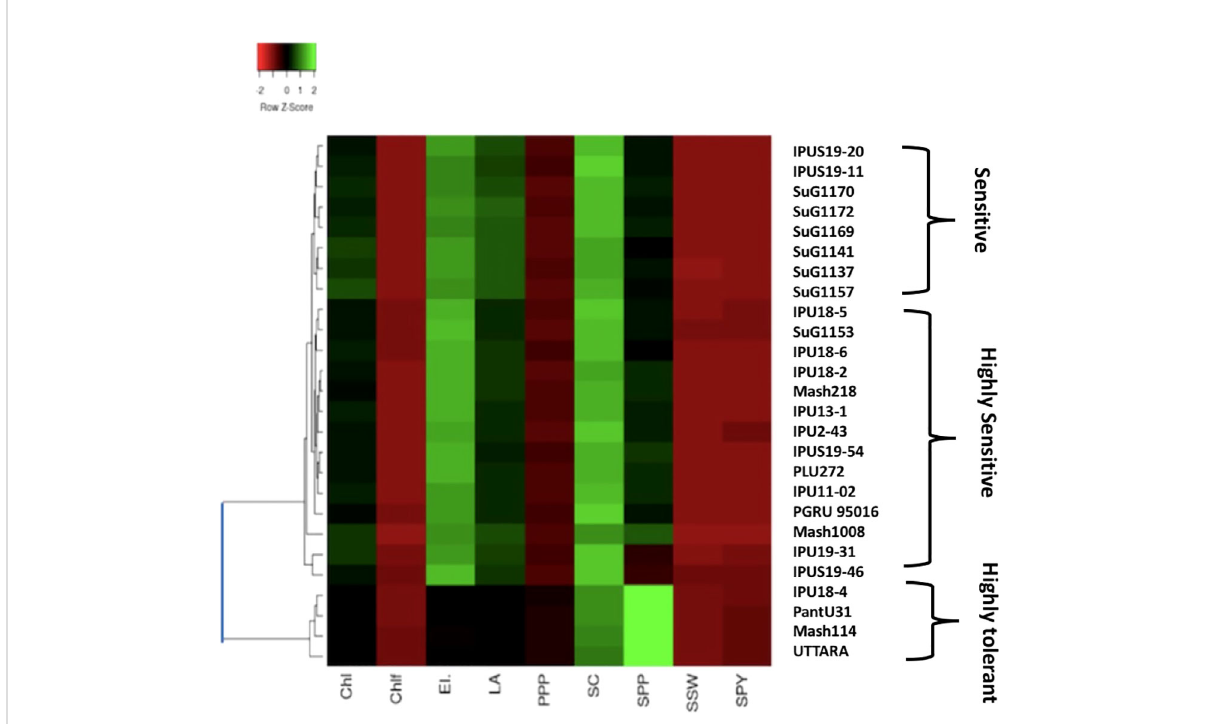
FIGURE 9 Heat map based on the response of urdbean genotypes to heat stress in the year